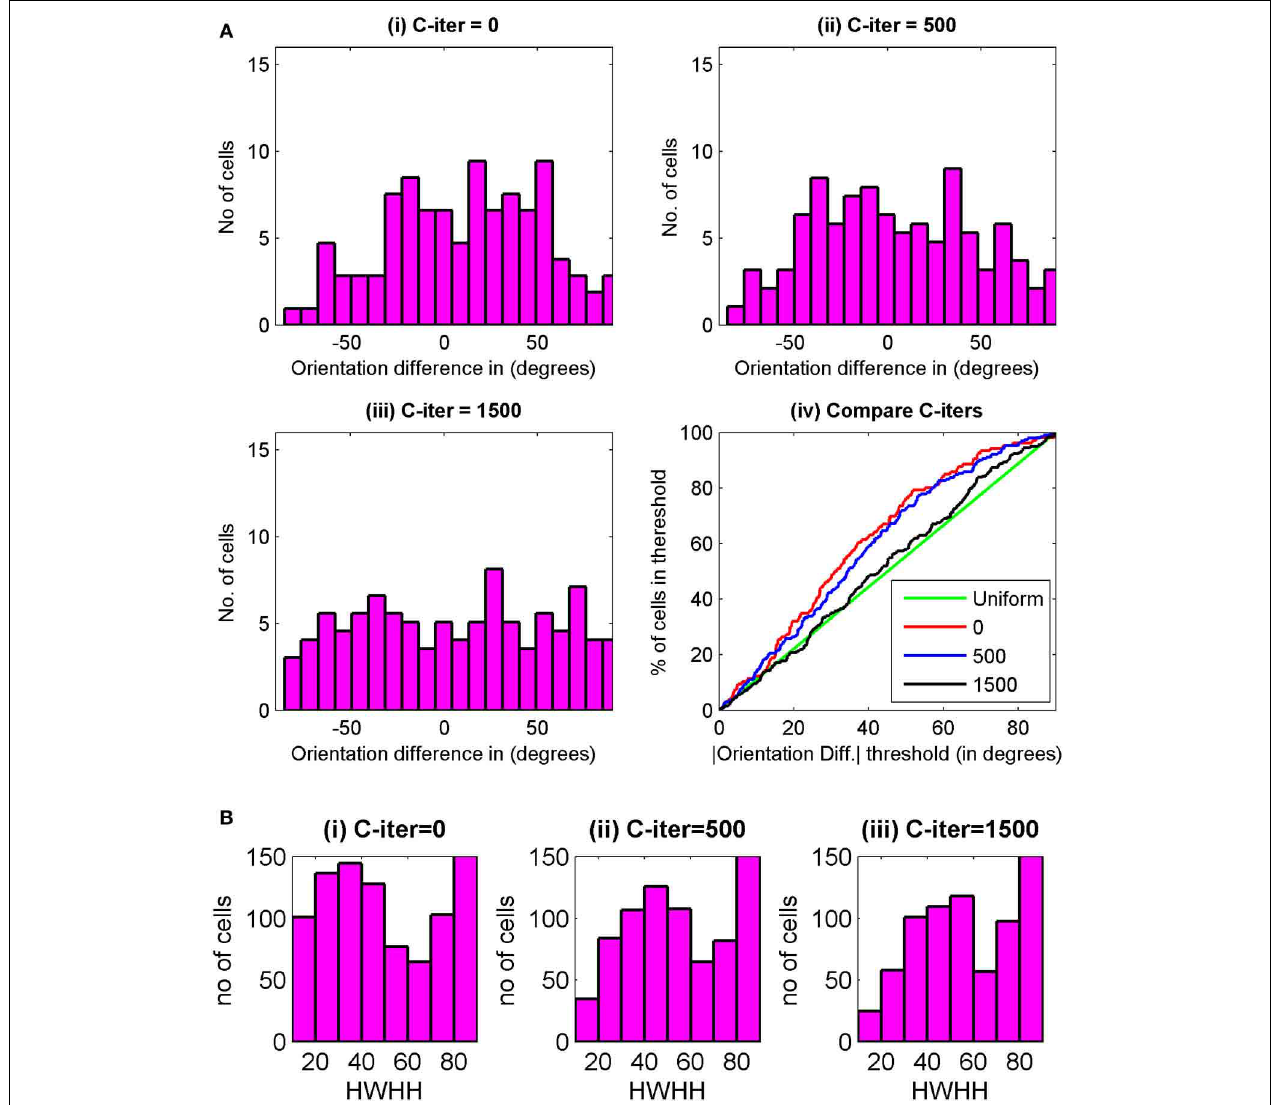
FIGURE 8 | (Ai–iii) Histogram of preferred orientation difference between the two eyes, (cid:7) OR, at maturity (3000th epochs) for C-iter = 0, 500, and 1500 for cells from the same 35 × 60 patch of cortex used for Figure 7 . (iv) The cumulative distribution of (cid:7) OR, at 3000 epochs is shown for